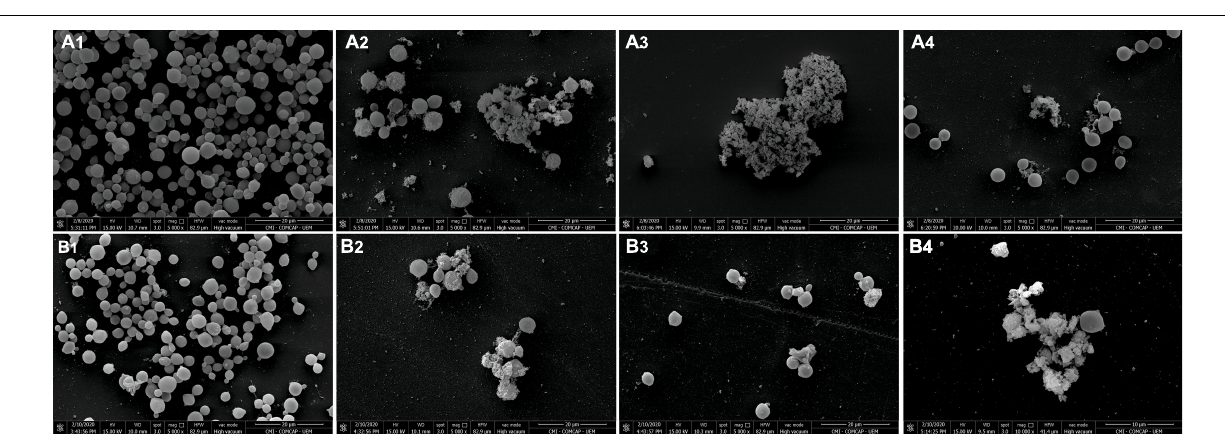
FIGURE 5 | Scanning electron microscopy (SEM) images of Cryptococcus neoformans ATCC 66031 biofilms on glass (A1–A4) and polystyrene (B1–B4) surfaces over 48 h of incubation at 37 ◦ C. (1) Untreated control; (2) 1,000.0 µ g/ml ethyl acetate fraction (EAF); (3) 2.0 µ g/ml amphotericin B (AmB); (4) 31.25/0.5 µ g/ml